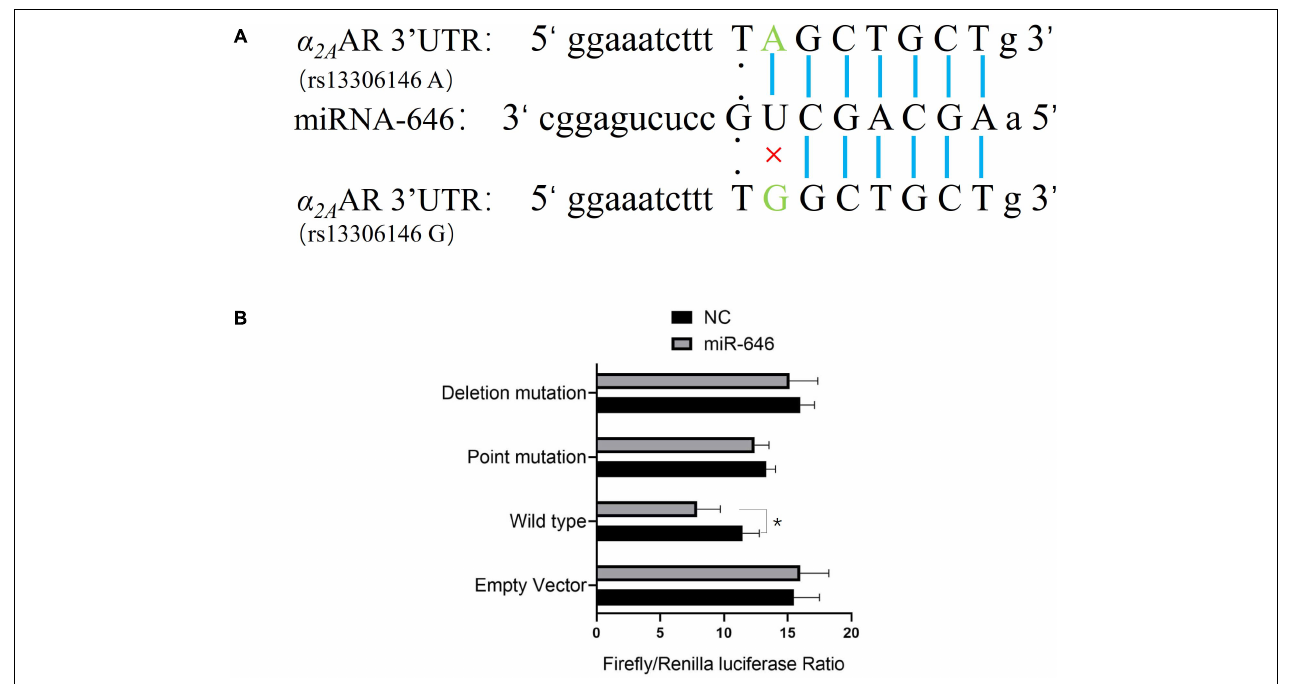
FIGURE 2 | miR-646 directly targets the α 2 A AR rs13306146 A allele. (A) Bioinformatics analysis of potential miR-646 binding to α 2 A AR rs13306146 polymorphisms. (B) Luciferase assay. HeLa cells were co-transfected with miRNA mimics or pMIR-Report (vector) of reference allele (A) and alternative allele (G) of α 2 A AR 3 (cid:48) UTR. Firefly luciferase signals were normalized with Renilla luciferase signals. The Renilla luciferase activity of each sample was normalized to the firefly luciferase value and plotted as relative luciferase activity. Data were presented as mean ± SD with the replication of n = 3. * p < 0.05.